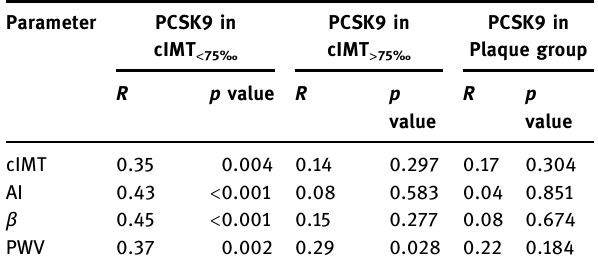
impact of PCSK9 together with age, gender, as well as LDL on cIMT values. The analysis revealed a signi fi cant e ff ect of age, sex and PCSK9 levels on cIMT values and therefore assumed that PCSK9 levels may act as a signi fi cant mediator of vascular changes side by side from LDL - C. We also assume the possible role of PCSK9 in early atherosclerotic changes as well as in the development of cardiometabolic changes, as described complementary results, observing increases in PCSK9 levels in patients with metabolic syndrome and type 2 diabetes. In these studies, PCSK9 levels correlated with the fi nding of atherosclerosis and degree of insulin resistance [ 24 ] .